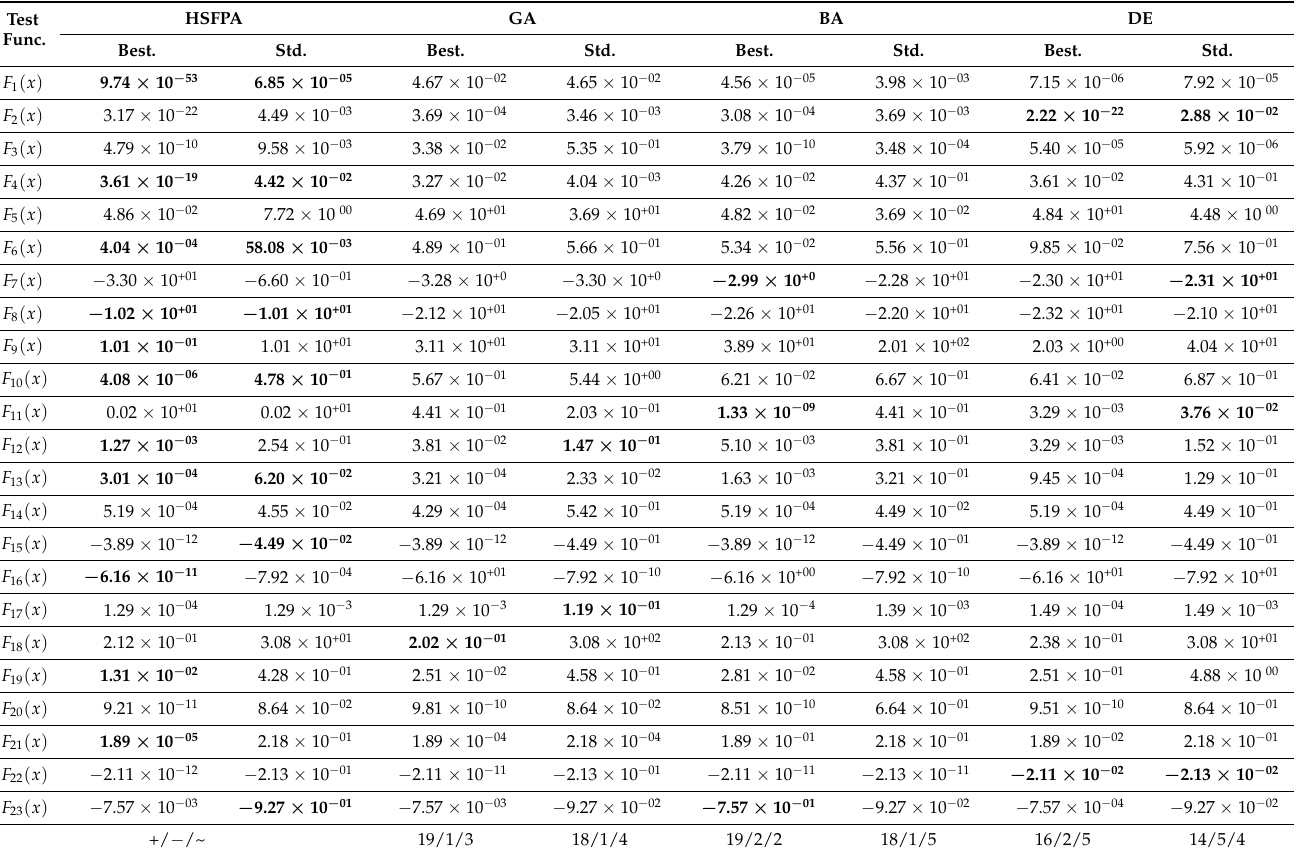
Table 3. The obtained results of the HSFPA are compared with the other algorithms, e.g., GA, BA, and DE algorithms, for the selected testing